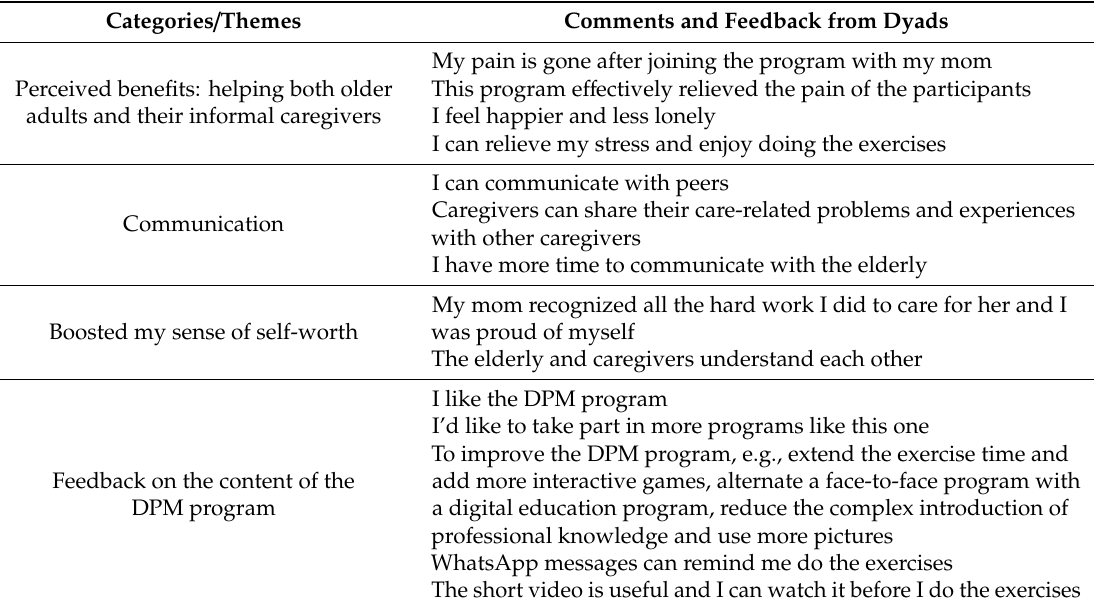
Table 6. Perspectives and experiences of informal caregivers and older adults. Categories /